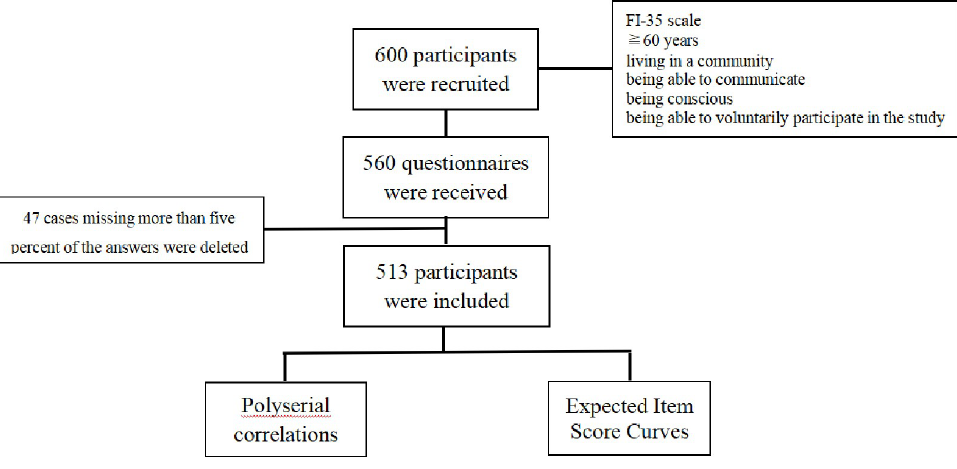
Fig 1. Flowchart of the